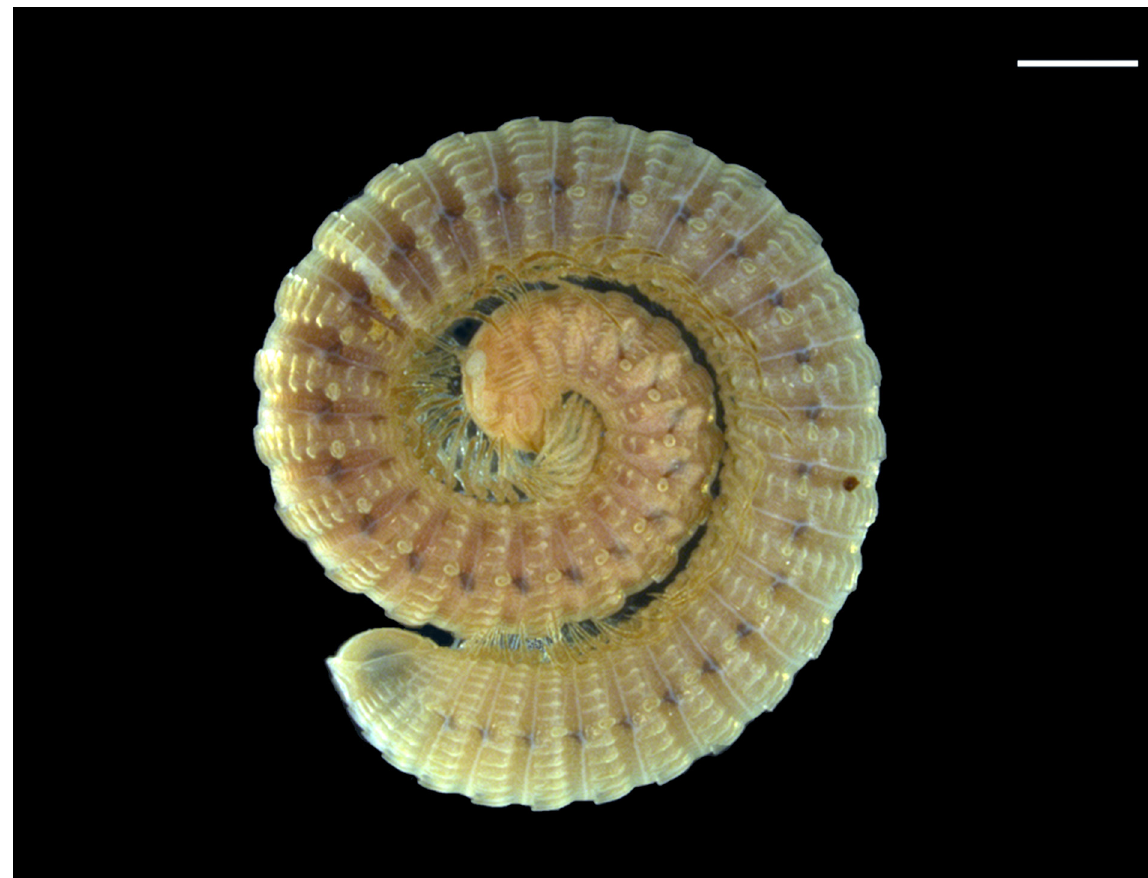
Fig. 1. Habitus of Chiraziulus troglopersicus sp. nov.,